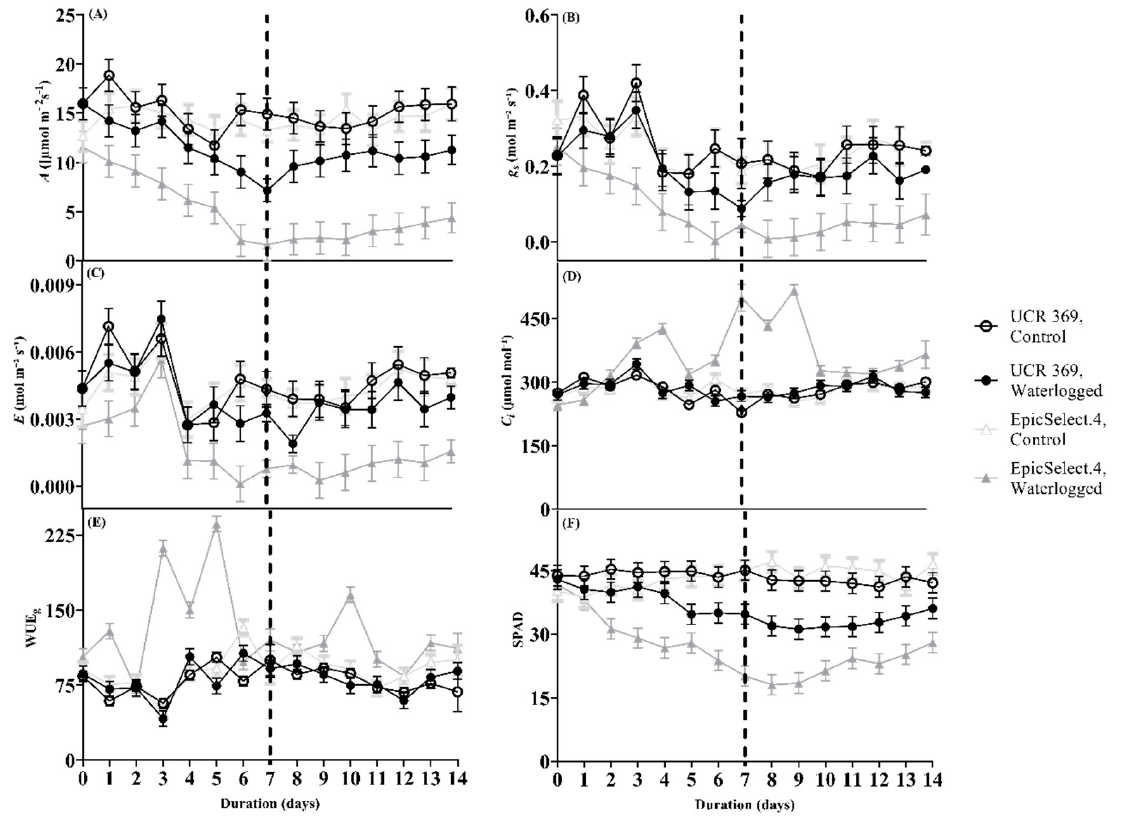
Figure 1. ( A ) CO 2 assimilation rate ( A ), ( B ) Stomatal conductance (g s ), ( C ) Leaf transpiration rate (E), ( D ) Intercellular CO 2 concentration (C i ), ( E ) Intrinsic water use efficiency (WUE), and ( F ) Chlorophyll content index (SPAD) of control and waterlogged cowpea genotypes (UCR 369 and EpicSelect.4) during and after 7 days of treatment. The dashed vertical lines in ( A – F ) demarcated the waterlogging from the recovery period. The error bar on the line graph indicates the standard error of the mean ± 5 replications of each leaf gas exchange trait. Standard error of the mean, A = 1.60; g s = 0.049; E = 0.0.0008; C i = 12.40; WUE = 7.93; SPAD = 2.39.